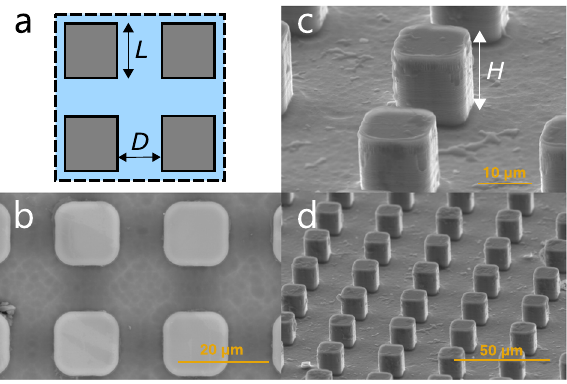
Fig. 1 SEM images of the microstructures. a Scheme of the square pillars distribution and de fi nition of the pillar side length L and spacing D . b Perspective view in detail of some real pillars at Scanning Electron Microscope (SEM) and de fi nition of the pillar height H . c Top view of some pillars at SEM. d Perspective view of some pillars at SEM.